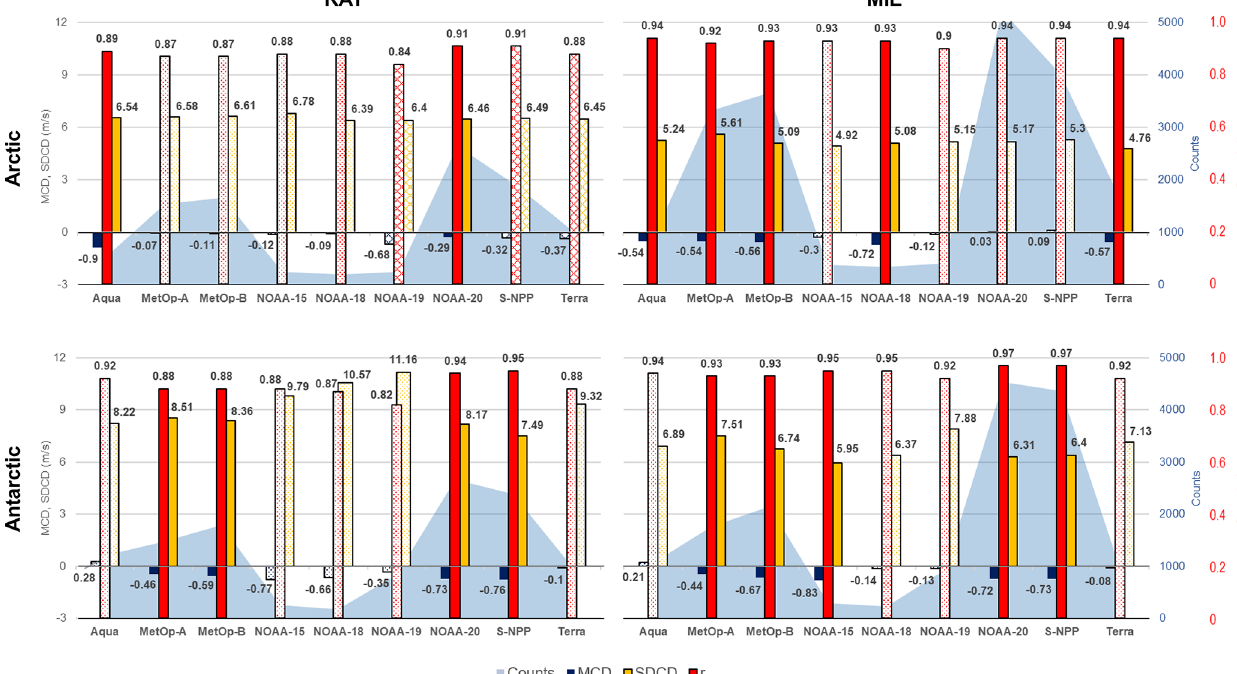
Figure 3. As in Fig. 2 but for LEO